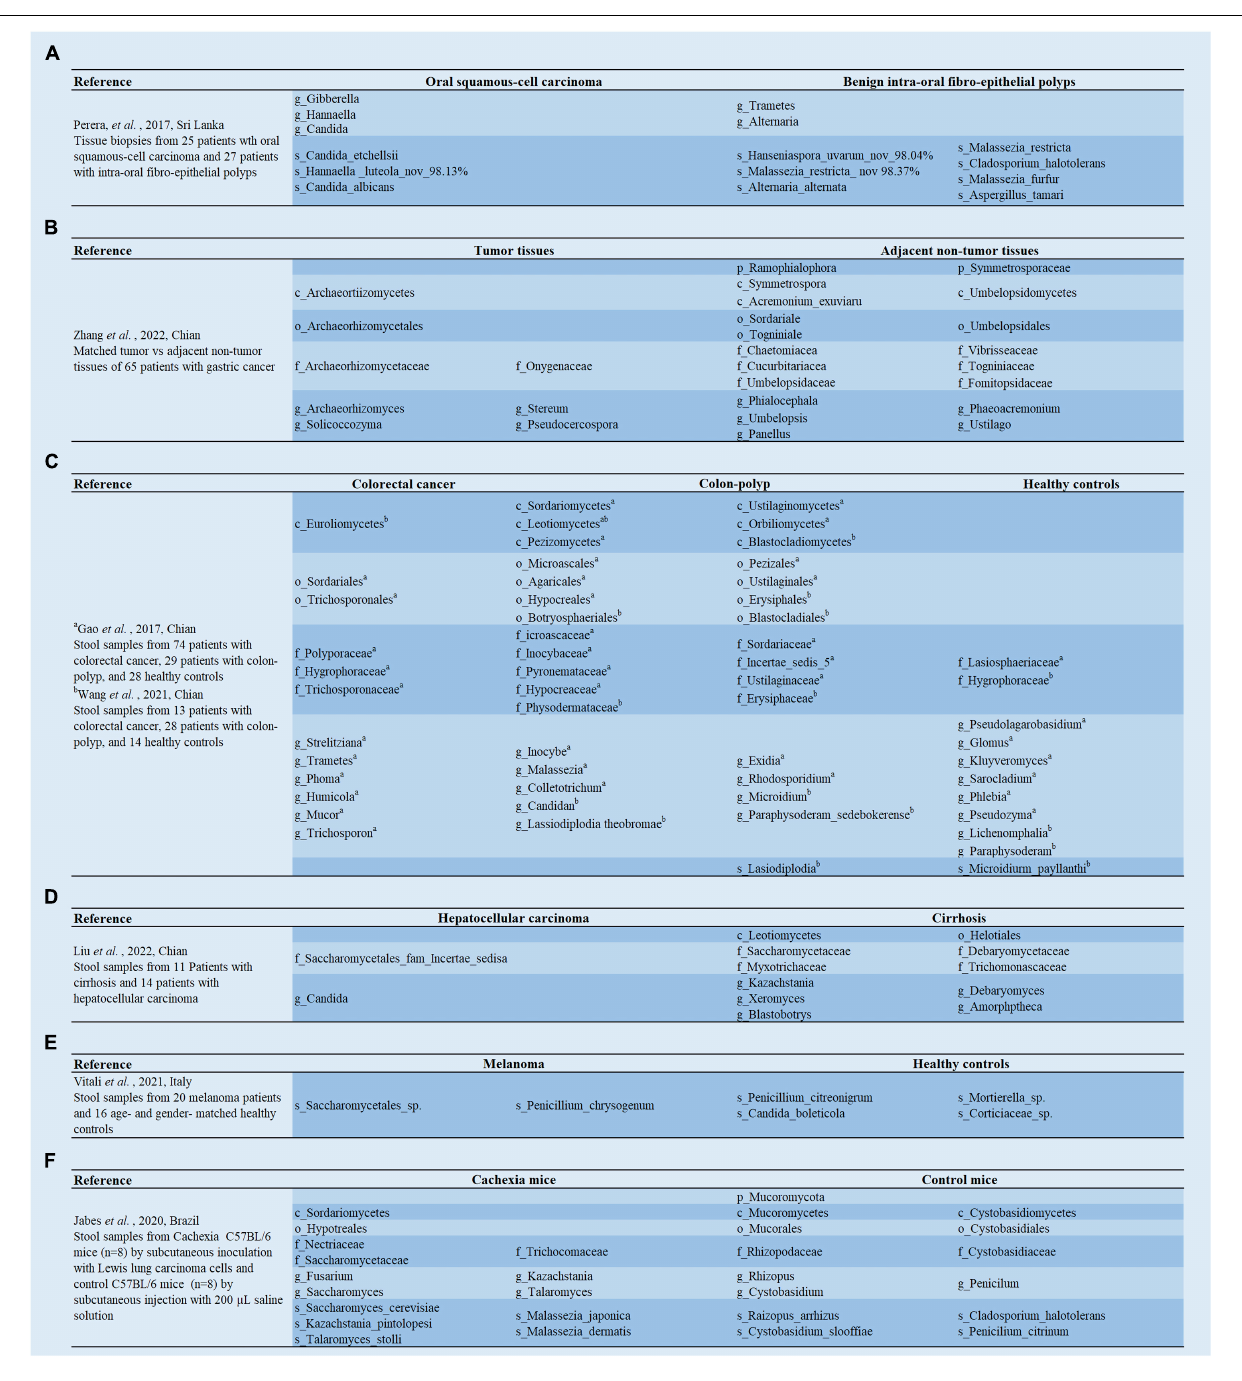
display an approximately 3,000-fold increase in fungi compared to normal pancreatic tissue in both human and mouse